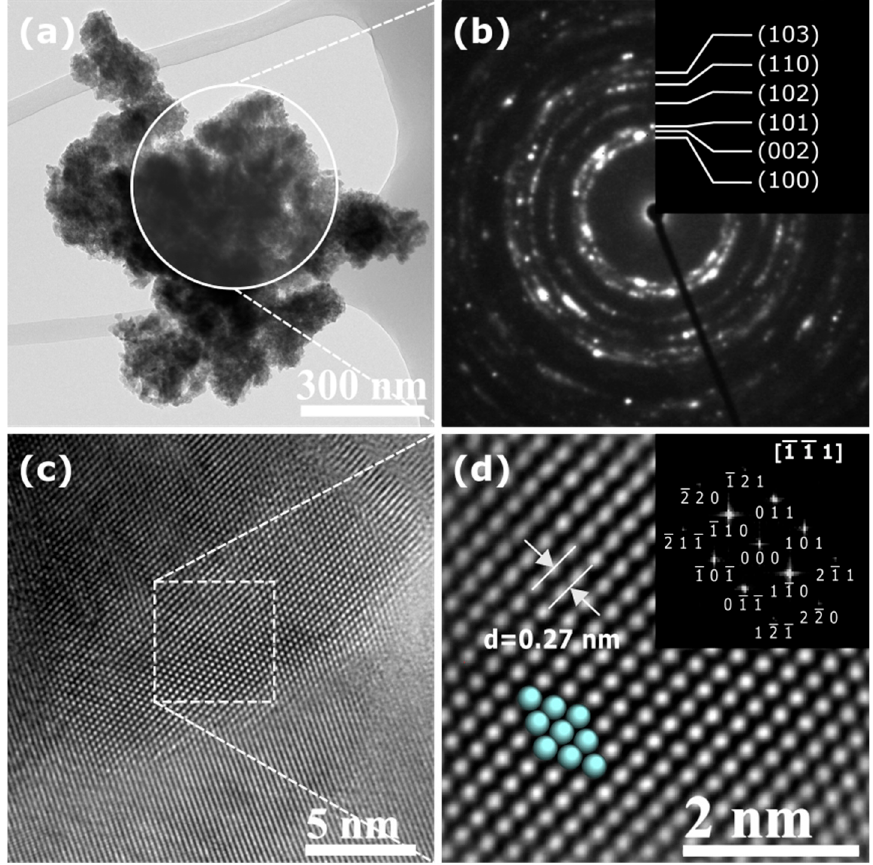
Figure 4. TEM images of ZnO NPs synthesized with Lentinula edodes : ( a ) ZnO NPs aggregates, ( b ) indexed SAED pattern, ( c ) HRTEM image of a ZnO nanoparticle, and ( d ) image in ( c ) processed with GMSS together with the FFT pattern.